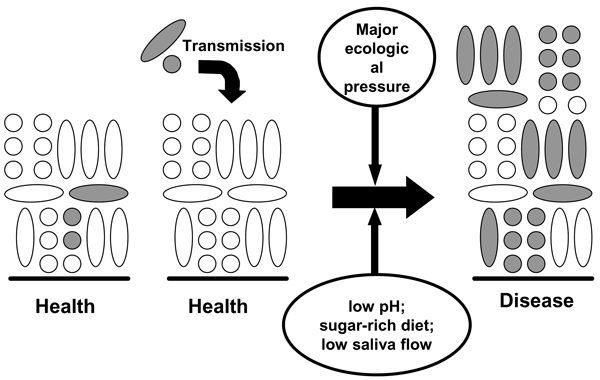
Schematic representation of the relationship between the microbial composition of dental plaque in health and disease. Potential pathogens (grey) may be present in low numbers in plaque, or transmitted in low numbers to plaque; both situations may be compatible with health. A major ecological pressure will be necessary for such pathogens to outcompete other members of the resident microflora (white) and achieve the levels (numerical dominance) needed for disease to occur. Possible ecological pressures for caries include a sugar-rich diet, conditions of low pH, or low saliva flow. Disease could be prevented not only by targeting the pathogen directly (e.g. with antimicrobial or anti-adhesion agents) but also indirectly by interfering with the ecological pressure responsible for the selection of the pathogen.